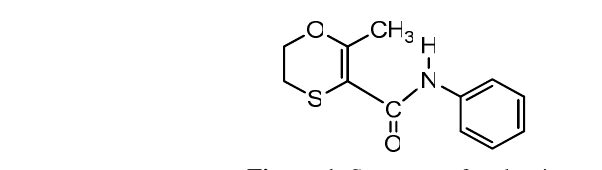
Figure 1. Structure of